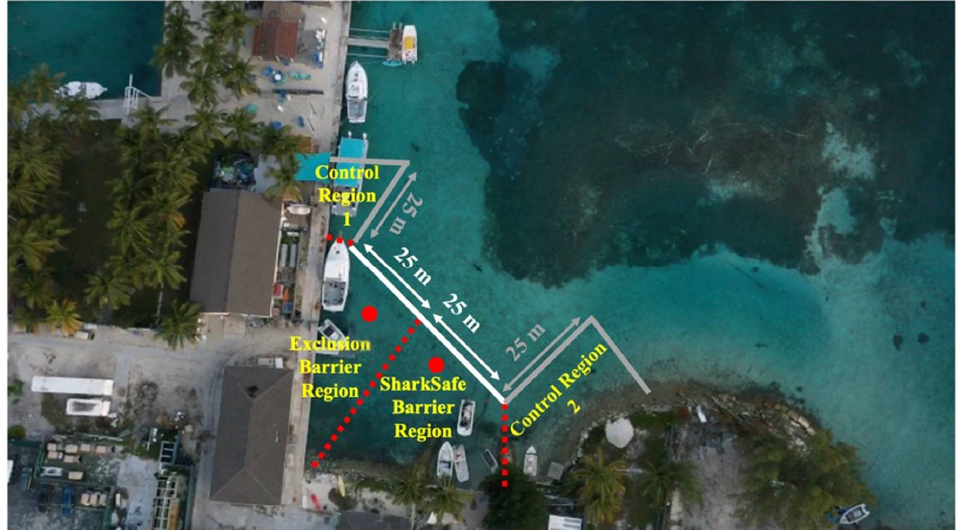
Figure 2. Aerial view of the barrier experimental setup in Bimini, Bahamas. This experiment consisted of four experimental regions: two control regions, one Sharksafe barrier region, and one Exclusion barrier region. Each region was 25 m in length. During experimentation, the bull shark ( Carcharhinus leucas ) behaviors were compared between the Exclusion barrier, the Sharksafe barrier and only one of the control regions. The control region used for each one-hour trial was randomly selected. The red circles represent approximate bait (bonito [ Sarda sarda ] or wahoo [ Acanthocybium solandri ]) deployment locations.